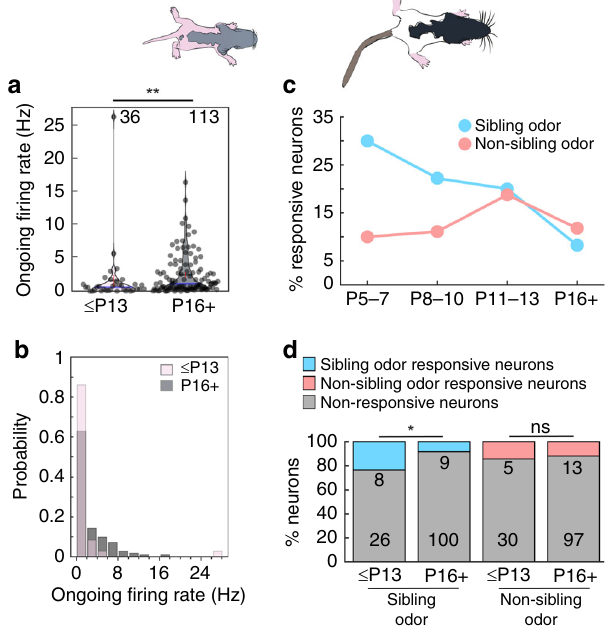
Fig. 7 Development of ongoing fi ring and kin-odor-responsive neurons in the lateral septum. a Ongoing fi ring rate was lower in young vs. old pups ( ≤ P13: n = 36; median = 0.59Hz; mean± s.e.m. = 1.59 ± 0.73Hz; P16 + : n = 113; median = 1.12; mean ± s.e.m. = 2.46 ±0.29 Hz; difference of medians = 0.53Hz; p = 0.004, Mann-Whitney rank sum test). Horizontal blue line is the median, horizontal black line is the mean. Error bars are s.e.m. b Probability histogram of ongoing fi ring rates (bins range from 0 to 30 in 2Hz increments). c Percentage of signi fi cantly suprathreshold responsive neurons with developmental age. As previously described, signi fi cance for stimuli was analyzed when number of trials was ≥ 3. Sibling odor signi fi cant neurons ( n = responsive:total neurons; P5 – 7 = 3:10 neurons, P8 – 10 = 2:9 neurons, P11 – 13 = 3:15 neurons, P16 + = 9:109 neurons). Non-sibling odor signi fi cant neurons ( n = responsive:total neurons; P5 – 7 = 1:10 neurons, P8 – 10 = 1:9 neurons, P11 – 13 = 3:16 neurons, P16 + = 13:110 neurons). exact test). Colored bars represent proportion of signi fi cantly responsive sibling or non-sibling neurons. Gray areas indicate proportion of neurons which were not signi fi cantly responsive. All tests are two-tailed. For detailed statistical information, see Supplementary Table 1. * p < 0.05, ** p < 0.01, ns not signi fi cant.